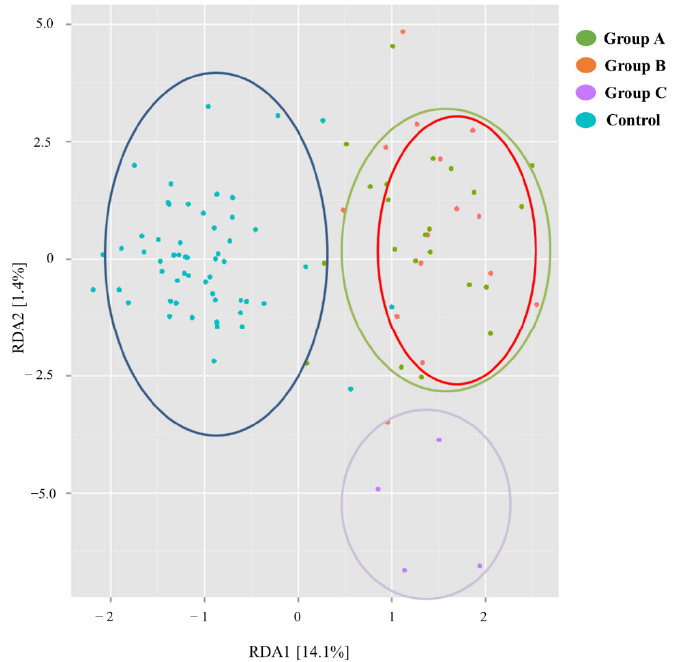
Figure 2. Redundancy Analysis plot comparing the microbiome of the Transplanted Intestine from Groups A, B and C, as compared with the control group. The transplant microbiome overall differs from the general population. Among the three transplant groups, Groups A and B are more similar and closer to the general population than Group C. According to this analysis, the microbiome of the transplanted intestine overall dif- fers from the microbiome of the general population. Among transplant recipients, those with stable allograft function in the long and short term (Group A and B, respectively) show a microbiome profile more similar to one another and closer to the general popula- tion, as compared to the microbiome of patients with unstable allograft (Group C). When analyzed at a phylum level, the similarity of the microbiome of patients in Groups A and B is confirmed, as shown in Figure 3.